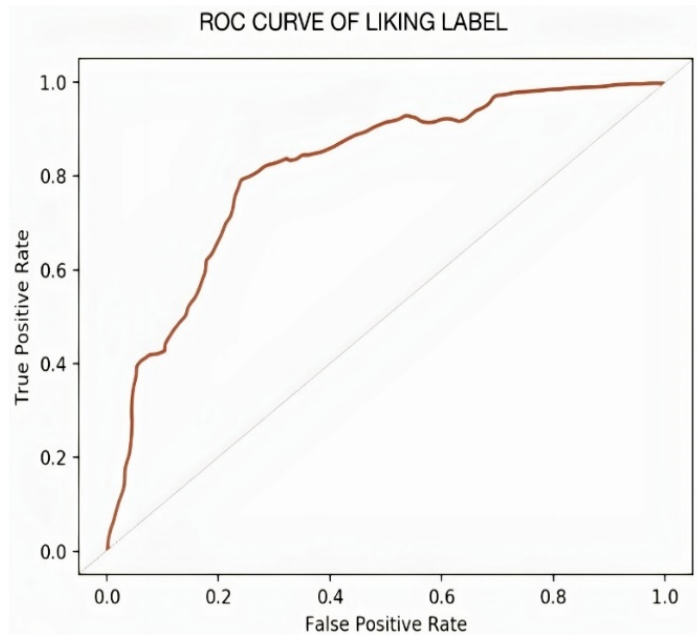
Figure 21. ROC curve of liking label.